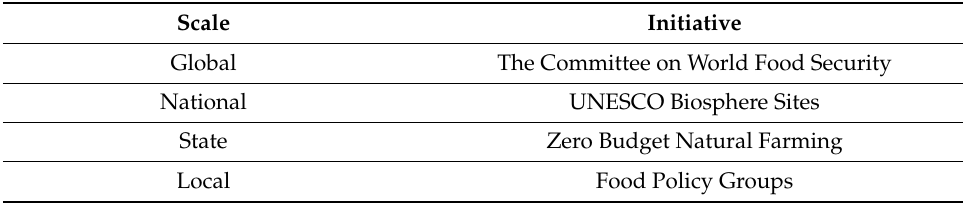
Table 1. Initiatives Across